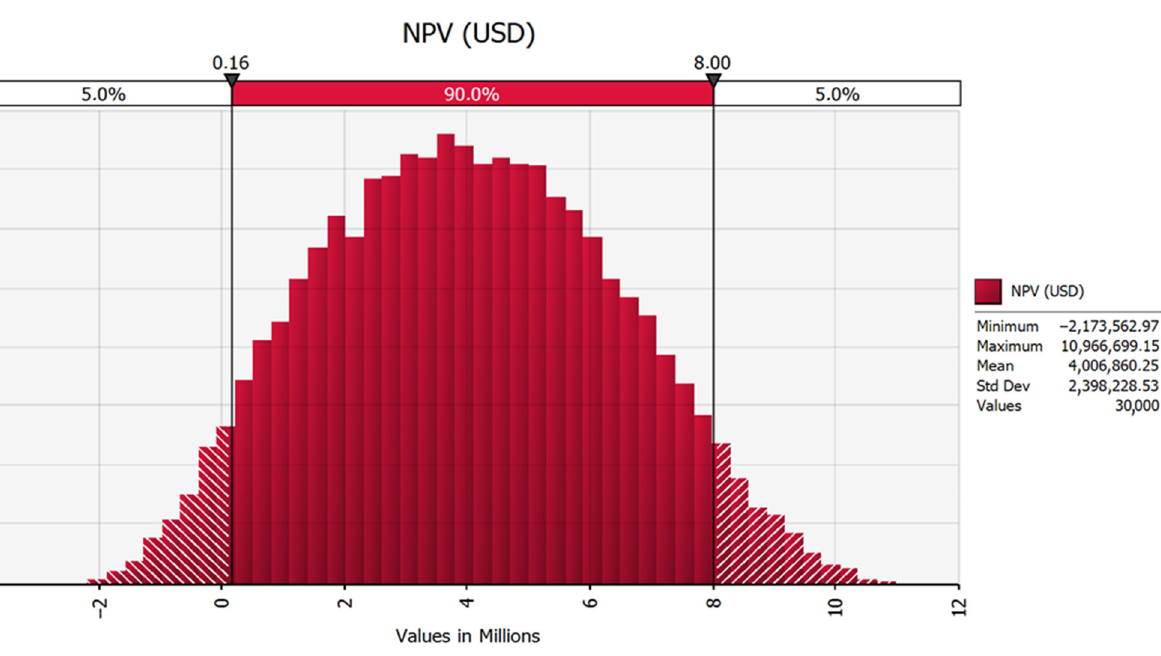
Figure 6. Investment of the studied cases for SL production by different substrates, supports and technology. (1) Jiménez-Peñalver et al. [41]; (2) Parekh et al. [25]; (3) Rashad et al., [12].